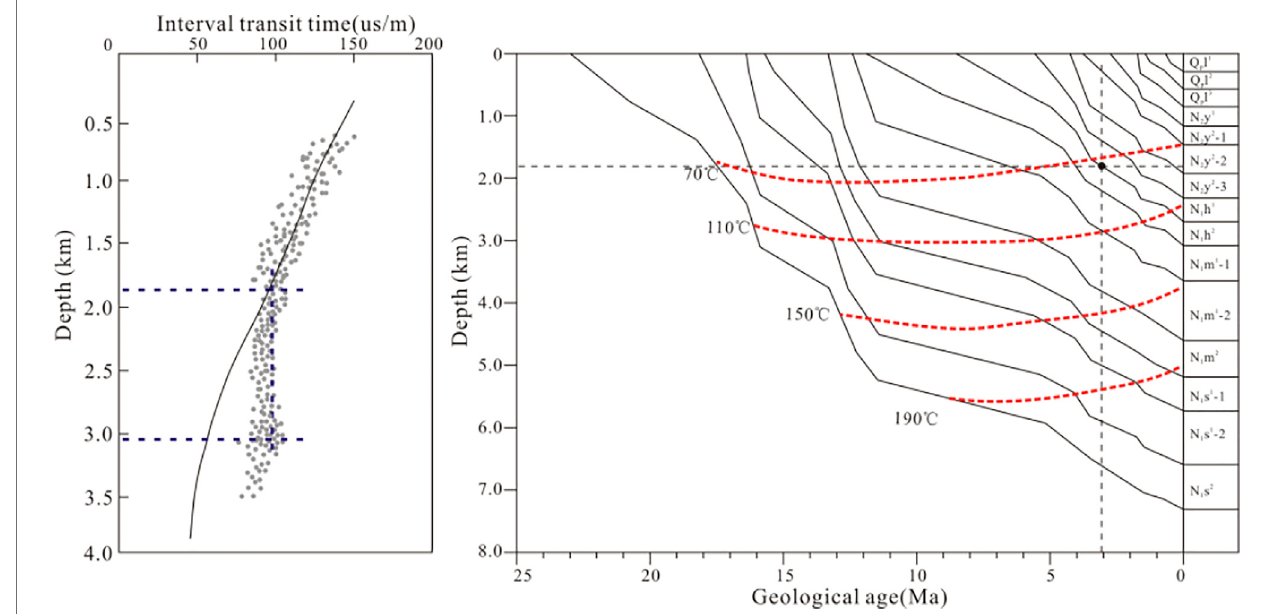
FIGURE 11 | Schematic diagram of the calculation theory about onset timing for overpressure in well AF-1 – 2.